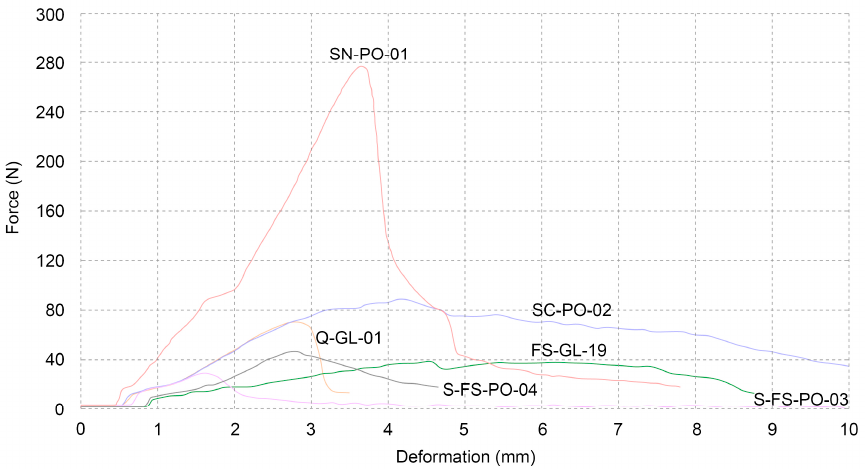
Figure 9. Three-point flexural test of various samples.